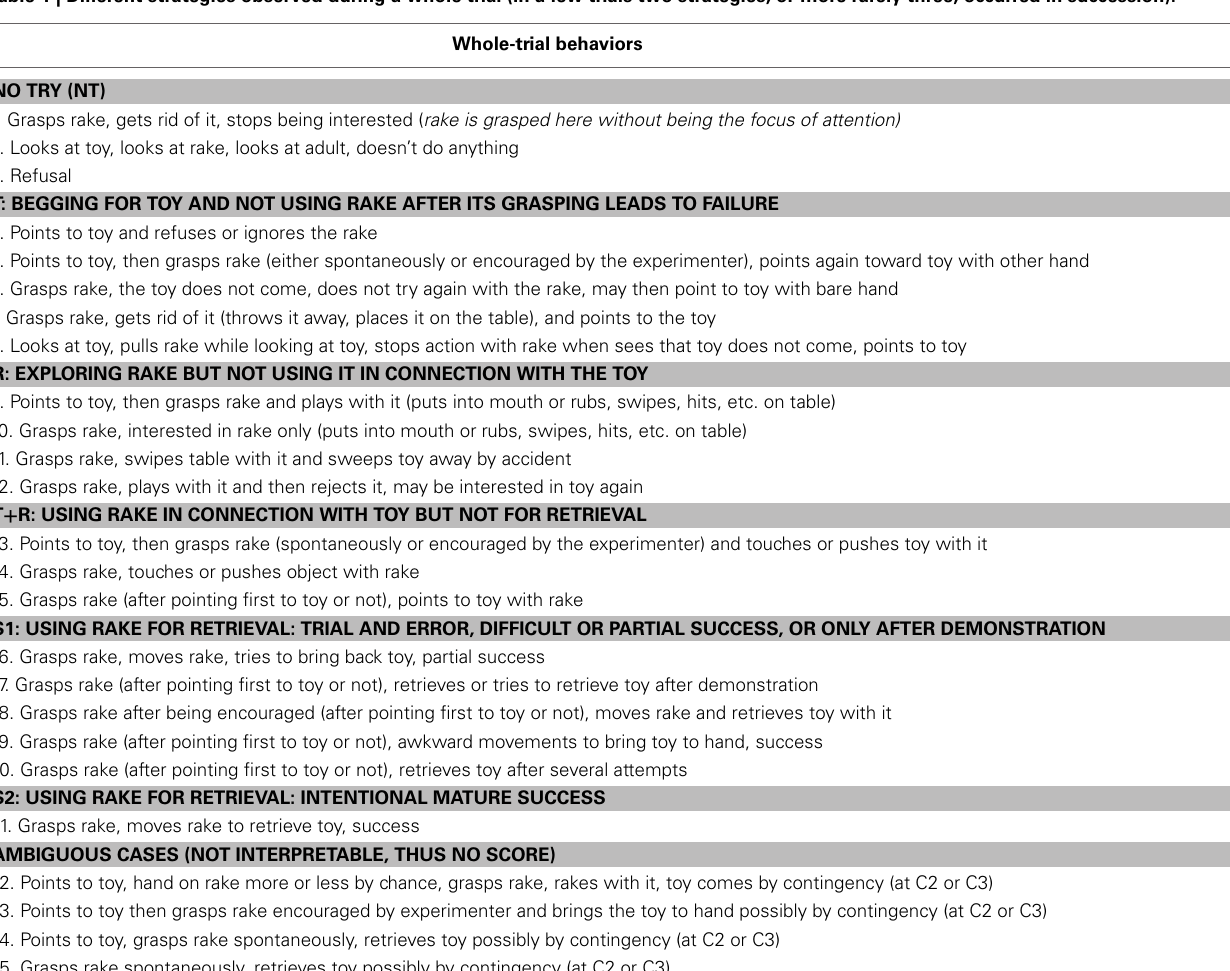
Table 1 | Different strategies observed during a whole trial (in a few trials two strategies, or more rarely three, occurred in succession). Whole-trial